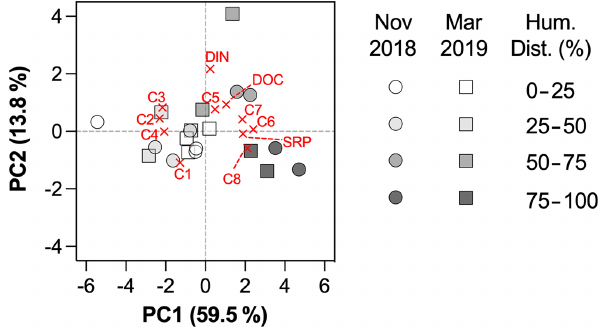
Figure 4. PCA biplot, including loadings plot for the input vari- ables and scores plot for stations. Markers are shaped according to the sampling period and colored according to a gradient of human disturbance (defined as the sum of % croplands and % urban areas, supplementary ordinal variable in the PCA).